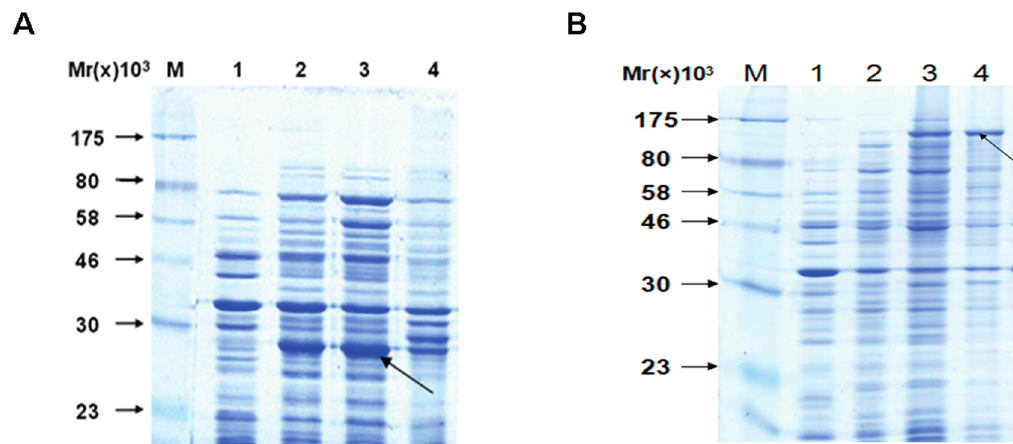
Figure 2. Identification of the fusion proteins apyrase-HIS/VirG-S by SDS-PAGE. (A/B) Line M: molecular weight marker: 175, 80, 58, 46, 30 and 23 kDa; Line 1: whole bacteria before induction; Line 2: whole bacteria after induction; Line 3: supernatant of the ultrasound crushing; Line 4: precipitate of the ultrasound crushing. Notes: ( A ) Analysis expression of apyrase protein; ( B ) Analysis expression of VirG